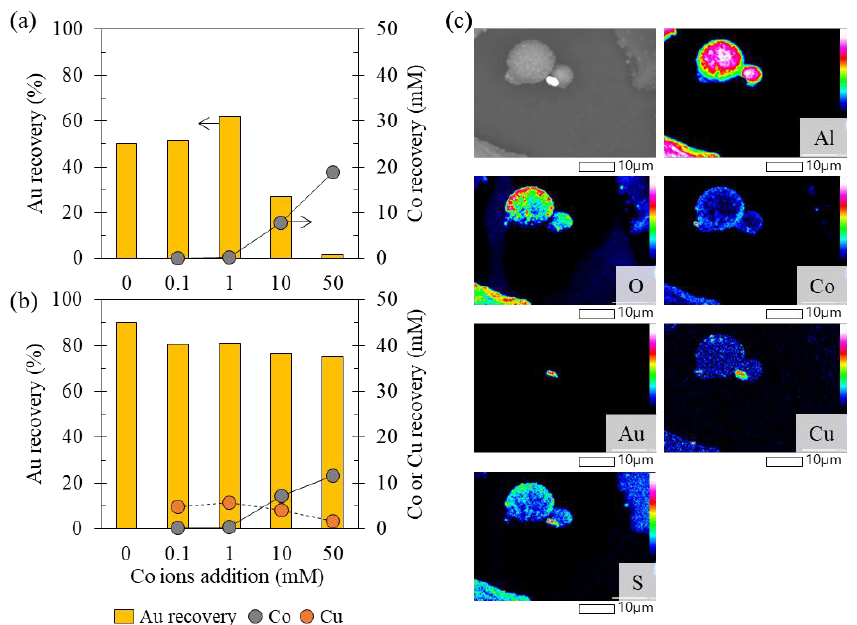
Figure 5. Recovery of gold ions from ammonium thiosulfate solutions with varying additions of Co ion concentrations from 0 to 50 mM ( a ) without and ( b ) with 10 mM of Cu ions in the solution, and ( c ) SEM photomicrographs with corresponding elemental maps of residue.